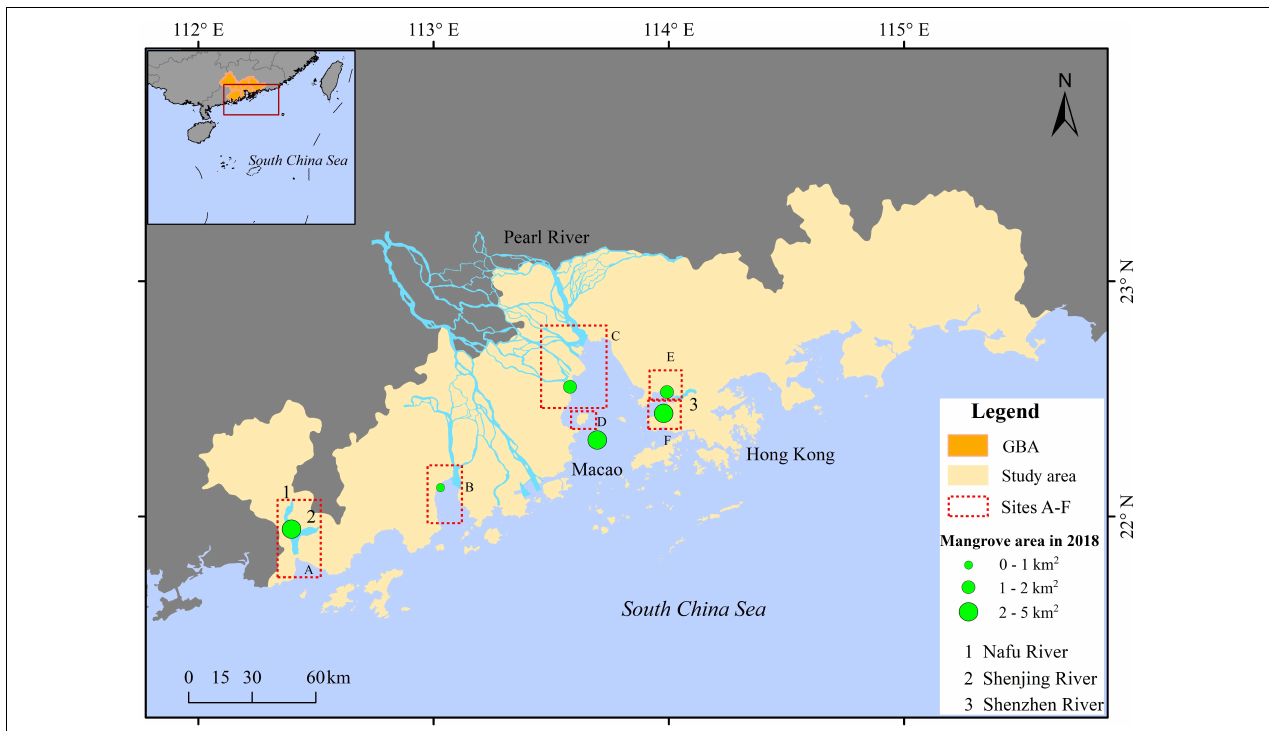
FIGURE 1 | The geography of Guangdong-Hong Kong-Macao Greater Bay Area. Boxes marked with letters (A–F) show the locations of main mangrove sites at the estuaries: (A) Zhenhai Gulf, (B) Huangmao Bay, (C) Lingding Bay, (D) Qi’ao Island, (E) Futian, and (F) Mai Po Nature